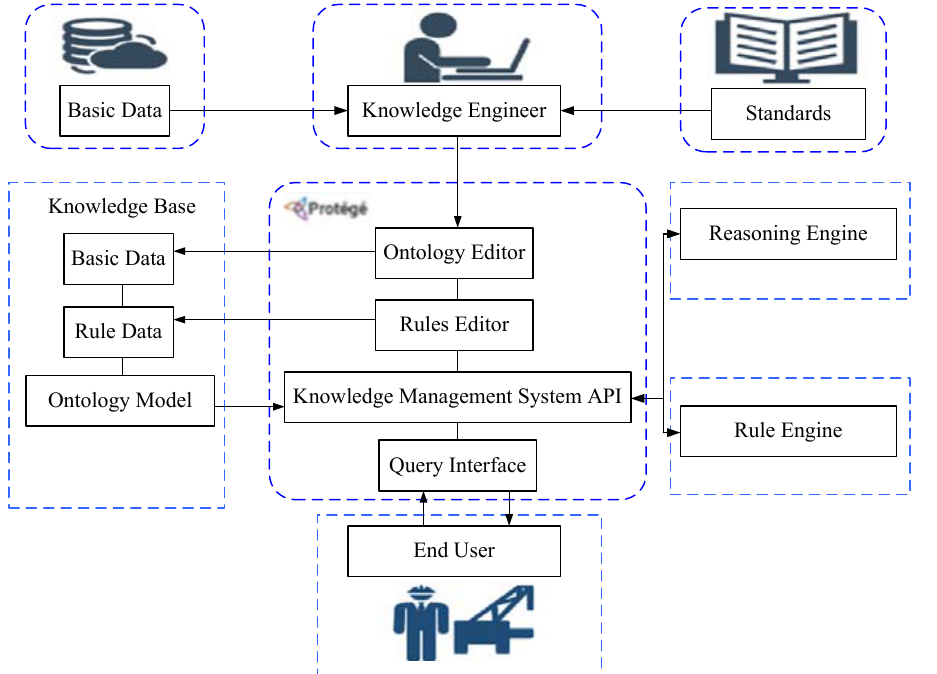
Figure 2. The developed framework of OntoEPS system.